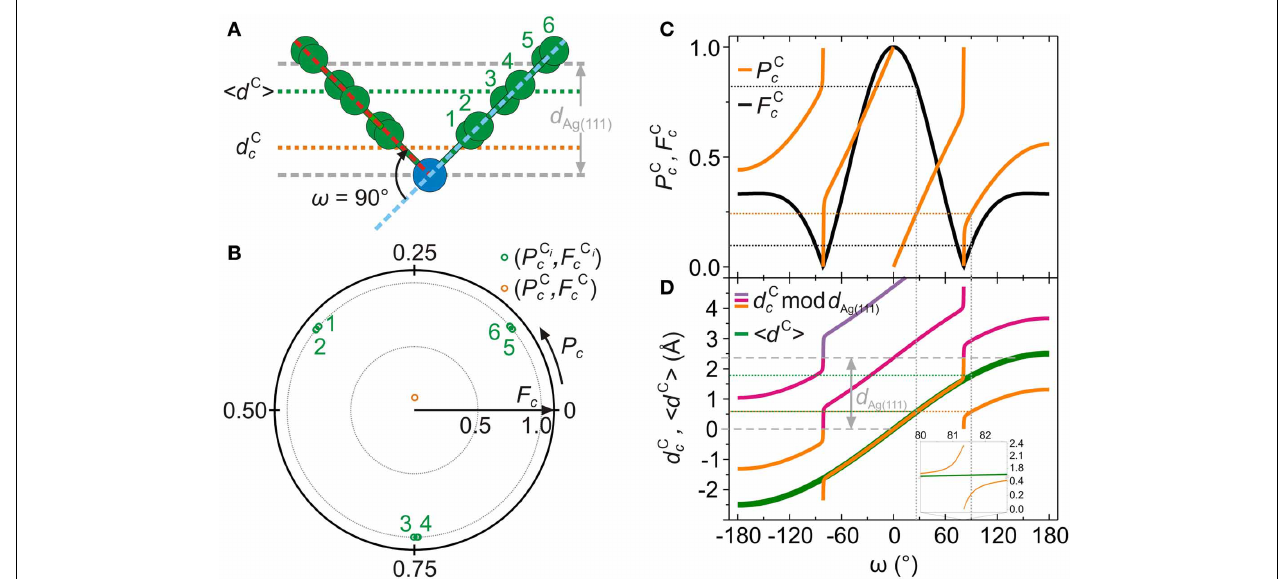
(cid:3) (cid:2) (C) Structure parameters P C c (orange solid curve) and F C c (black solid . (A) Hypothetical AB FIGURE 7 | The relation between d C c and d C curve) for − 180 ◦ ≤ ω ≤ 180 ◦ . (D) Orange solid curve: coherent carbon adsorption geometry with nitrogen atoms (blue circles) at the Bragg plane adsorption height d C c (in Å) for − 180 ◦ ≤ ω ≤ 180 ◦ . Note that d C c = ( d N c = 0mod d Ag ( 111 ) ), ω = 90 ◦ and β = 0 ◦ (see section 4.2 and Mercurio et al. [34] for the definition for ω and β ). Orange dotted line: coherent P C c × d Ag ( 111 ) − d Ag ( 111 ) for ω < 0 ◦ (section 4.4), while d C c = P C c × d Ag ( 111 ) carbon adsorption height d C c calculated using Equation (1). Green dotted for ω > 0 ◦ , with P C c values from (C) . Magenta solid curve: d C c (orange line: true average carbon adsorption height (cid:7) d C (cid:8) calculated using Equation solid curve) + d Ag ( 111 ) . Violet solid curve: d C c (orange solid curve) + (6). (B) Green circles: structure parameters ( P C i c , F C i c ) of the individual 2 × d Ag ( 111 ) . Green solid curve: true average carbon adsorption height (cid:7) d C (cid:8) carbon atoms in (A) . Orange circle: structure parameters ( P C c , F C c ) of the (in Å) for − 180 ◦ ≤ ω ≤ 180 ◦ . Inset: enlargement of (D) at ω ≈ 81 ◦ . Gray (cid:6) (cid:5) , calculated using Equations (2, 3, 9 – 12). 2 π iP C c sum vector F C c exp dashed lines: Bragg planes at 0Å and